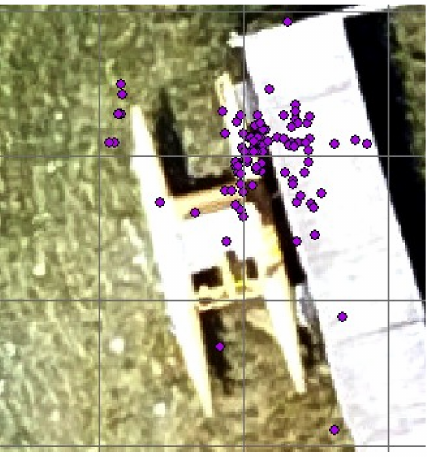
Figure 10. Photogrammetric and radar images of paddle